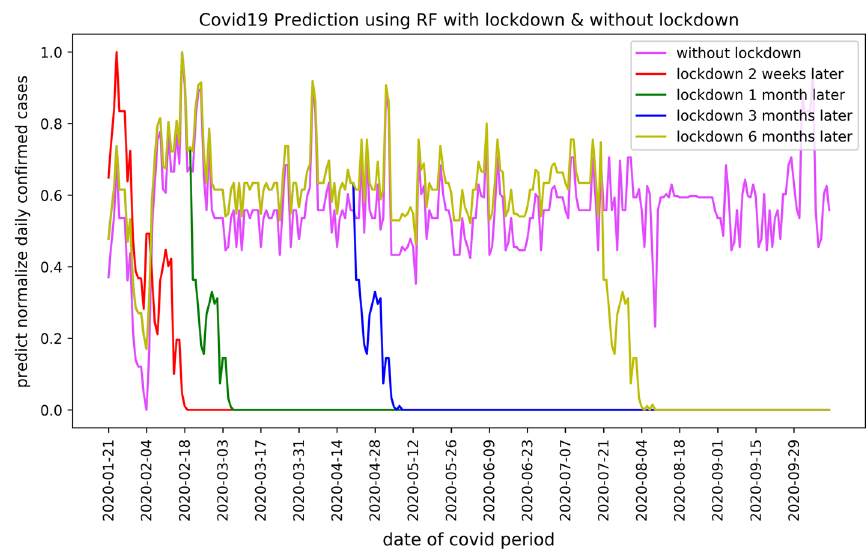
Fig. 6 Predicted COVID-19 confirmed cases using Random Forest